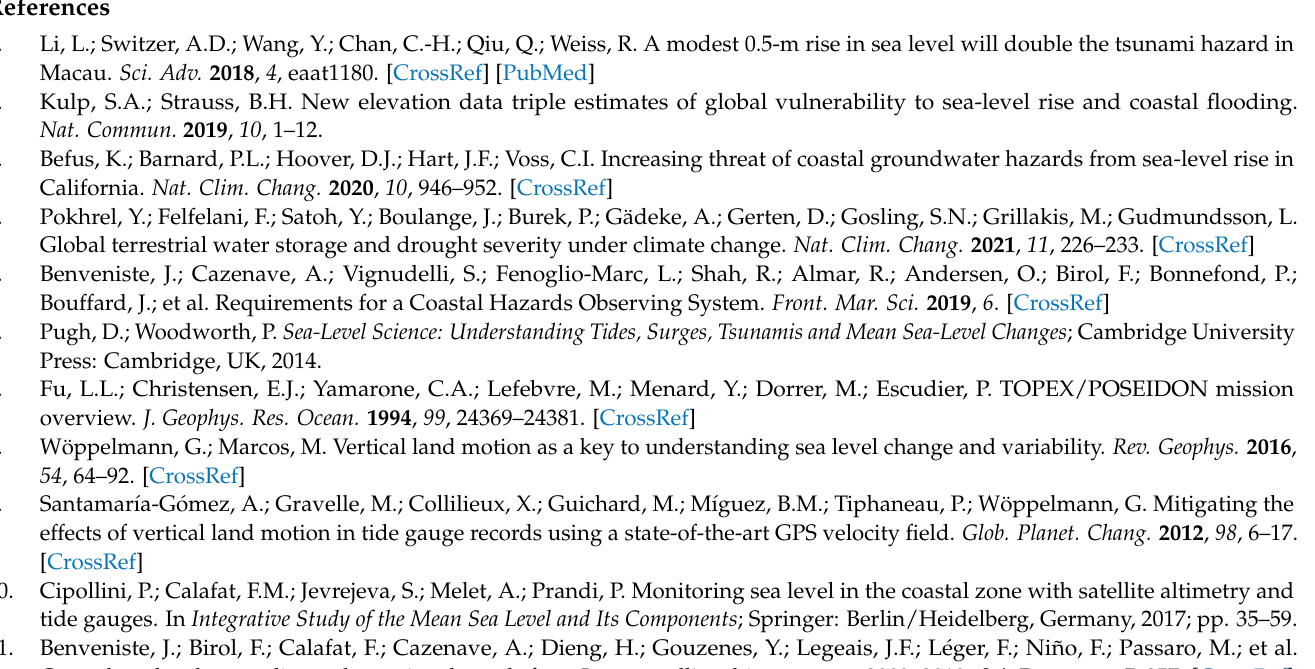
Figure A10. GPS measured vertical displacement at BRST with ( bottom panel ) and without ( Top panel ) offset corrected.